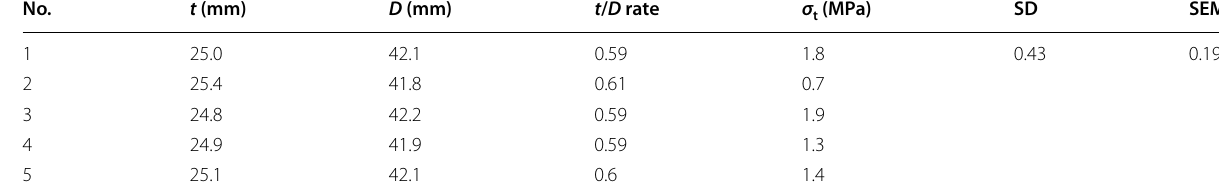
Table 3 STS test results when the water–cement rate was 0.42. No.